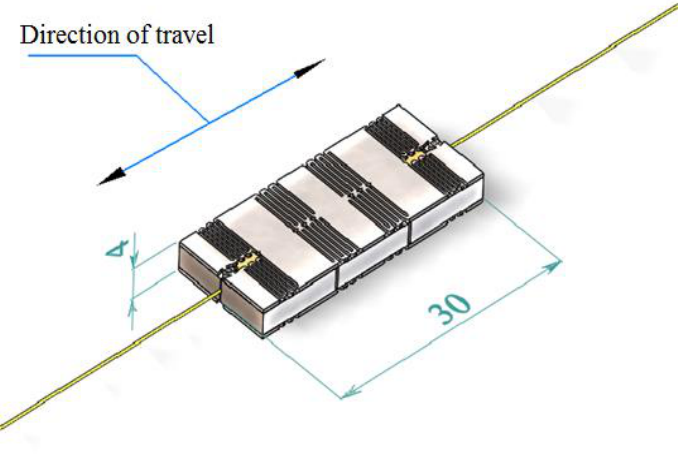
Figure 2. General view of the developed piezoelectric linear